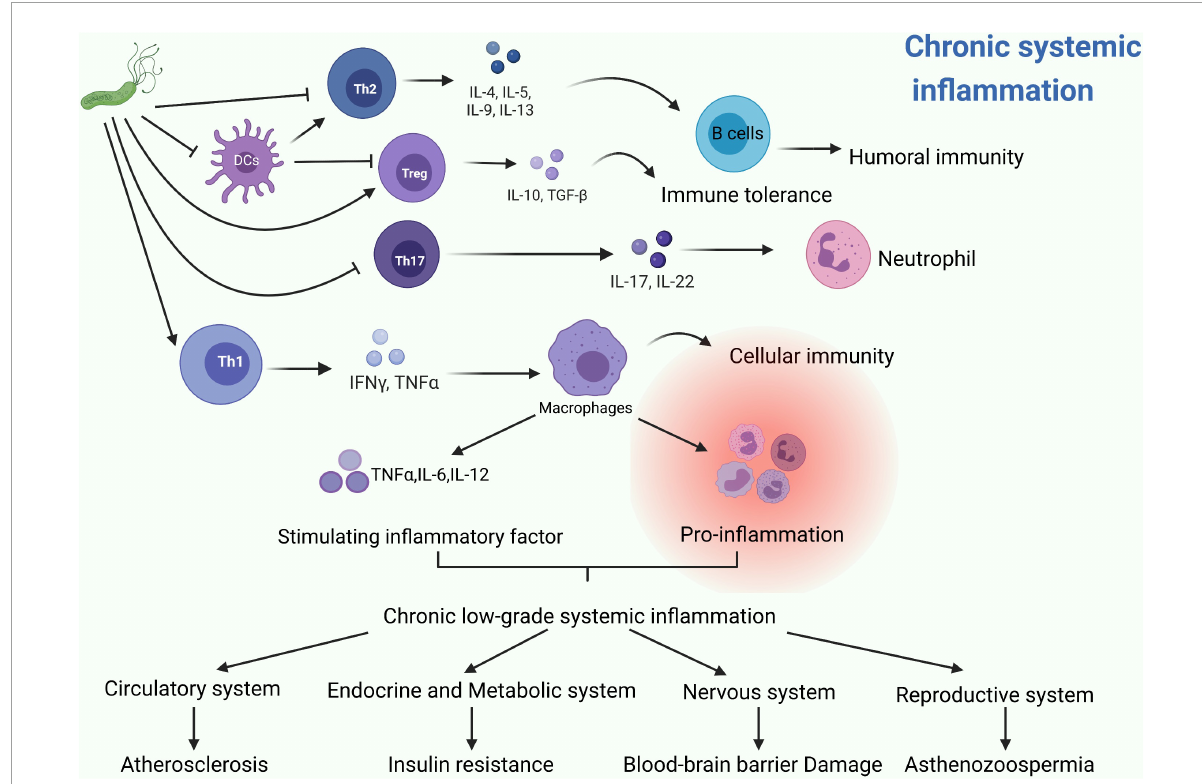
FIGURE3 The possible common mechanisms by which H. pylori induces these systemic diseases can be summarized into two promising hypotheses: Hypotheses 1. Since Helicobacter pylori can induce several inflammatory factors, such as IL-1/2/6/8/10, TNF- α and IFN- γ , these factors may lead to chronic low-level systemic inflammation in the human body and ultimately represent diseases (Franceschi et al., 2014). Typical disorders due to H. pylori -induced inflammatory factors turbulence include: atherosclerosis (de Boer et al., 2000), insulin resistance (Cheng et al., 2017), blood-brain barrier damage, brain neurodegenerative disease (Efthymiou et al., 2017), and decreased sperm motility (Figura et al.,